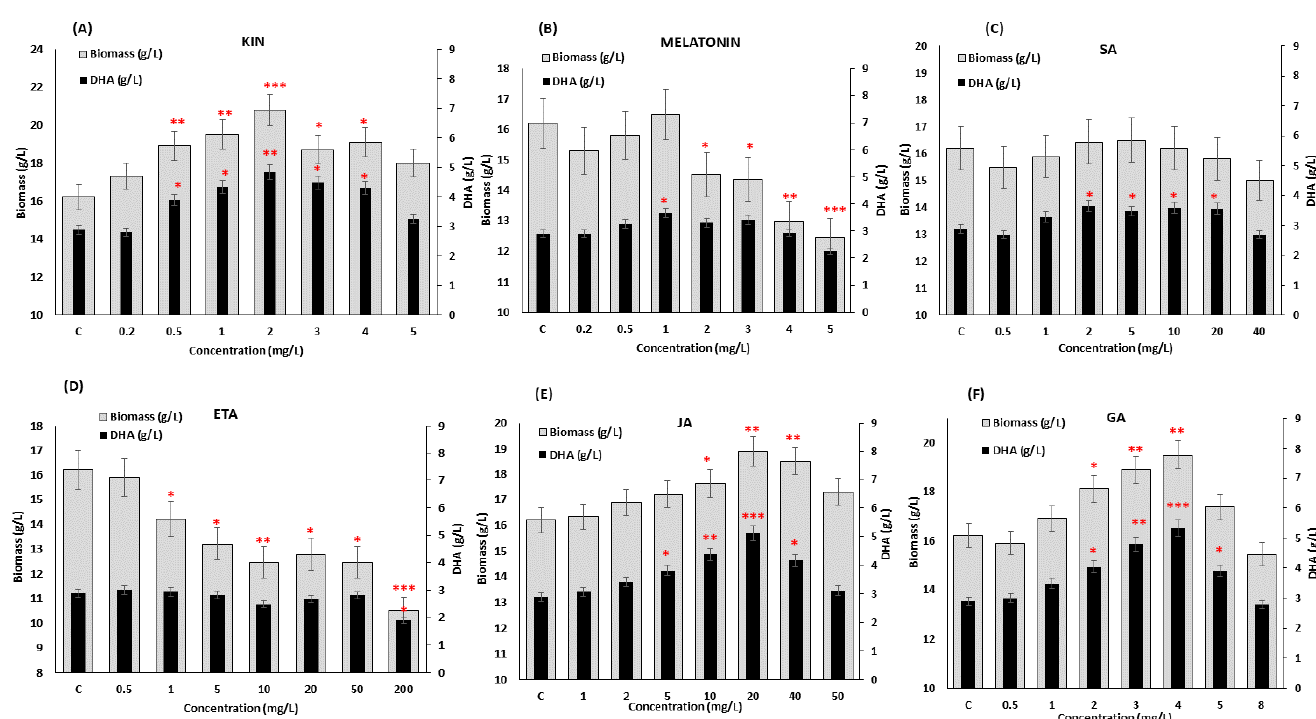
Figure 1. Screening of the effect of different concentrations of ( A ) KIN, ( B ) Melatonin, ( C ) SA, ( D ) ETA, ( E ) JA and ( F ) GA on biomass and DHA production in SW1 after 96 h of cultivation. Values and error bars represent the means and the standard deviations of triplicate experiments ( n = 3). (*), (**) and (***) represents the statistical significance with respect to control values at p < 0.05, p < 0.01 and p < 0.001, respectively. The C represents the control of the experiment where no phytohormones were added to the medium.